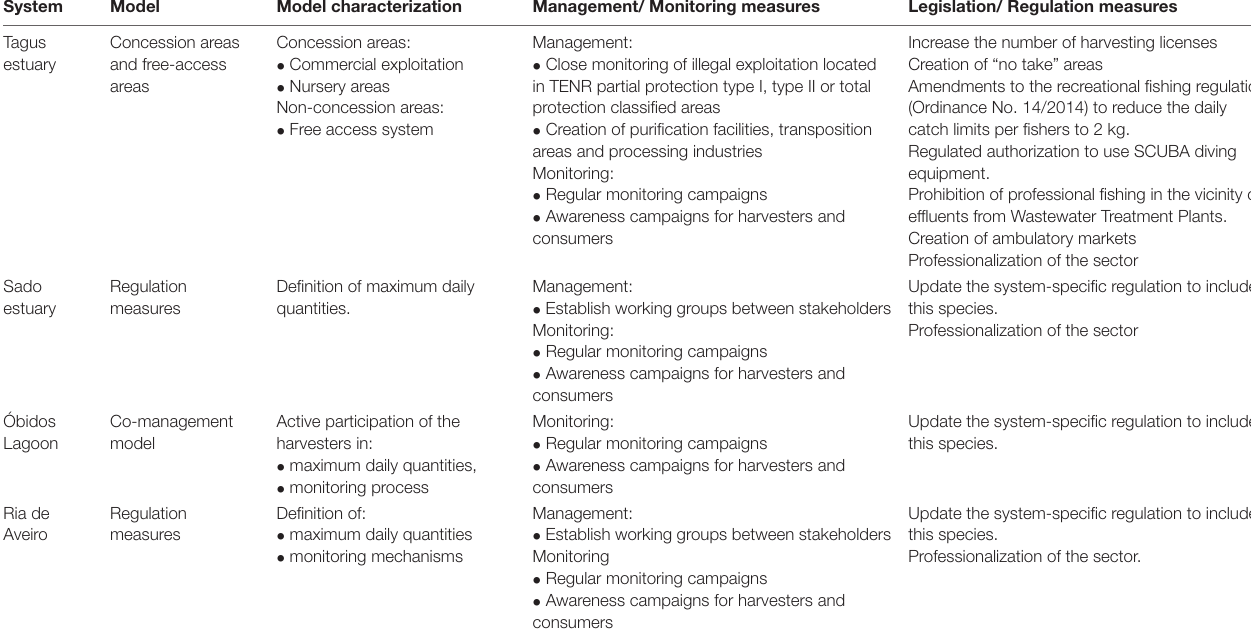
TABLE 4 | Summary of the management models proposed for the Portuguese estuarine and lagoon systems and respective characterization and additional measures.